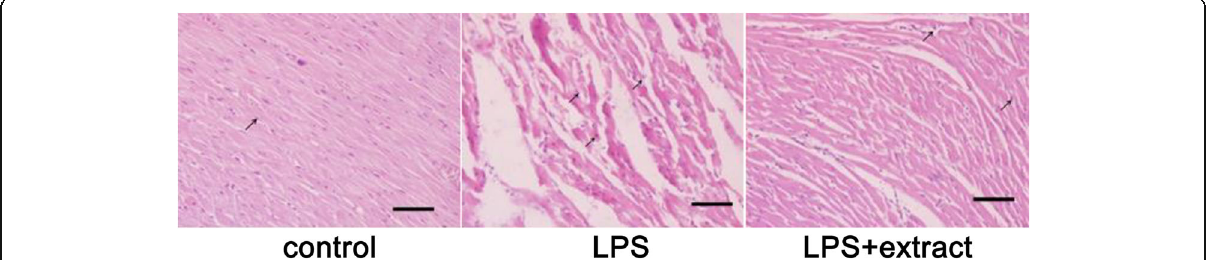
Fig. 4 Morphometric change. Heart samples were collected 6 h after injection with LPS, fixed in formalin, and sections were cut and stained with hematoxylin-eosin. Scale bar: 50 μ m. 400 ×